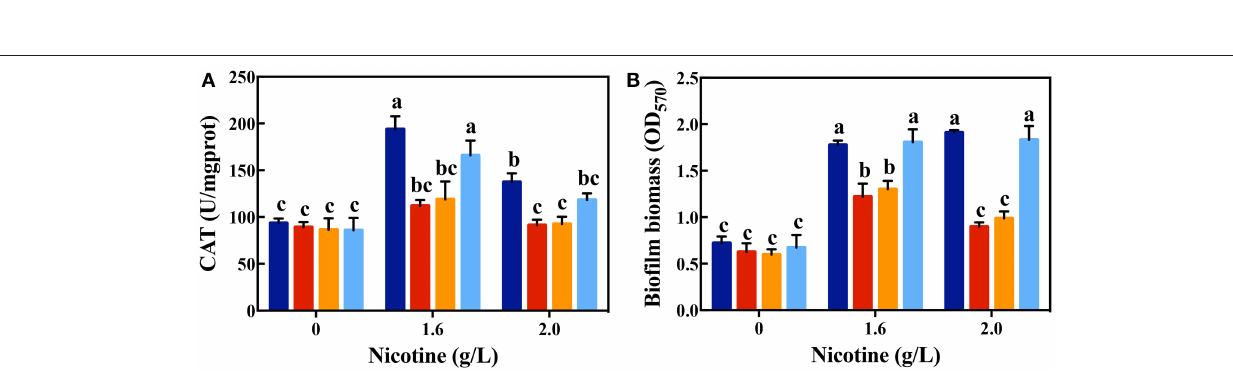
FIGURE 6 | CAT activity (A) and biofilm formation (B) after complementing 1 lasI strain with 3OC12-HSL on exposure to different concentrations of nicotine (WT: dark blue bars; 1 lasR : red bars; 1 lasI : orange bars; 1 lasI + 3OC12-HSL: light blue bars). Different letters indicate significant difference at p < 0.05 and the same letter indicates no significant